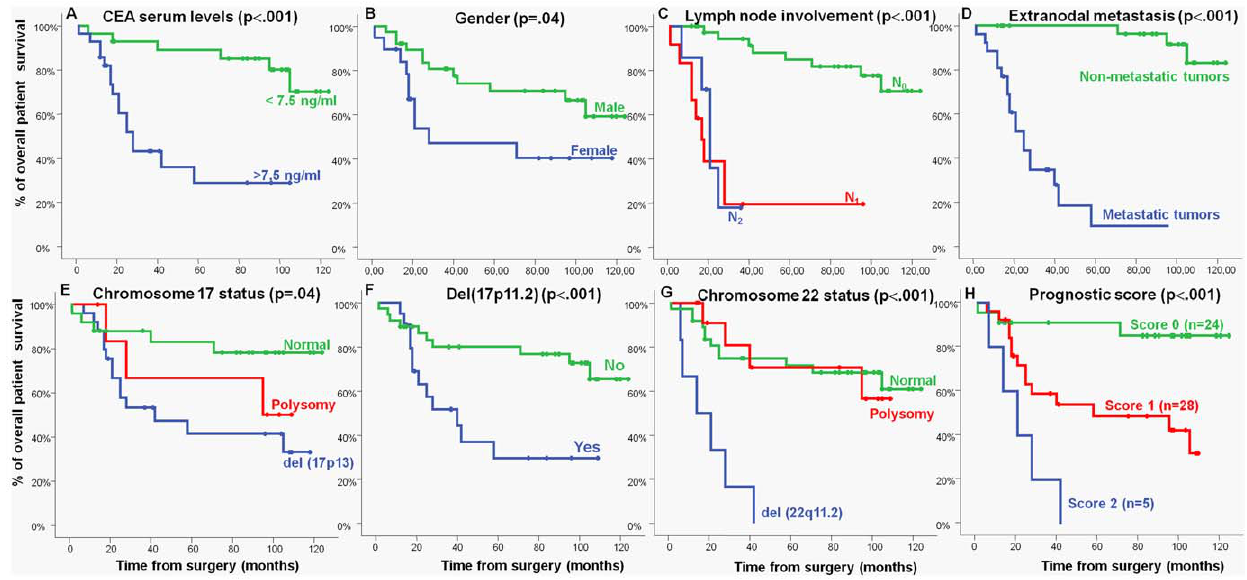
Figure 3. Clinical, biological and genetic characteristics of sCRC patients which showed a significant impact on overall survival in the univariate analysis: (A) carcinoembryonic antigen (CEA), (B) gender, (C) lymph node involvement, (D) occurrence of distant metastasis, (E) chromosome 17 status, (F) del(17p11.2) (G) chromosome 22 status, and (H) prognostic score established on the basis of the two most informative independent prognostic factors -del(17p11.2) and chromosome 22 status; p , .0001-.